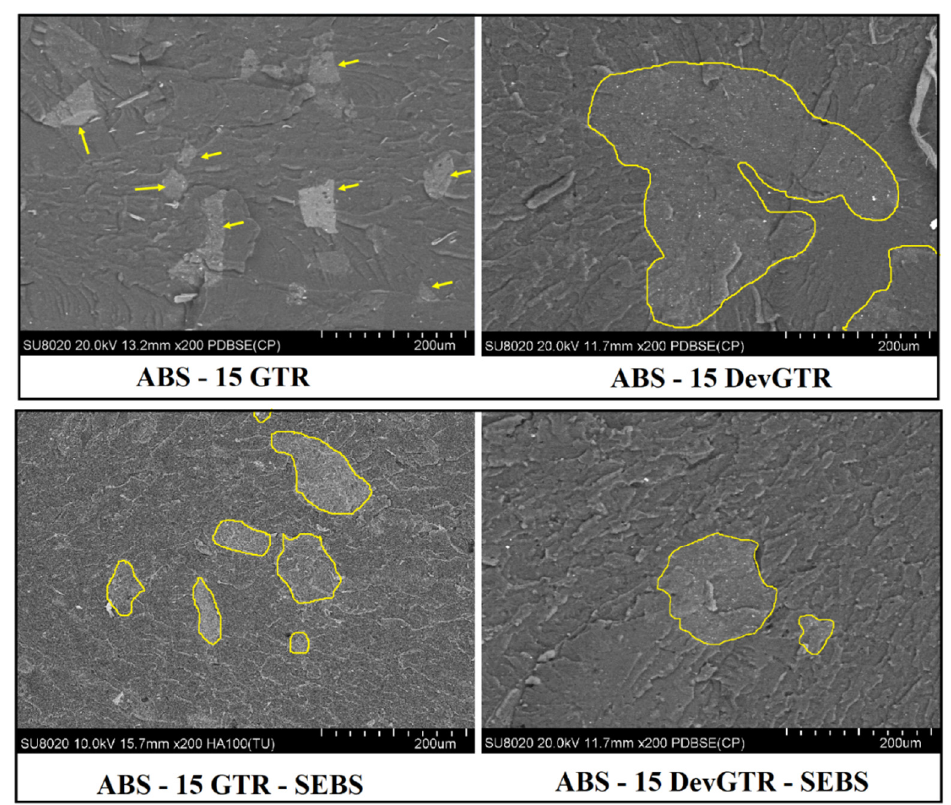
Figure 5. SEM micrographs of ABS-based materials containing GTR or DevGTR with or without the addition of SEBS.